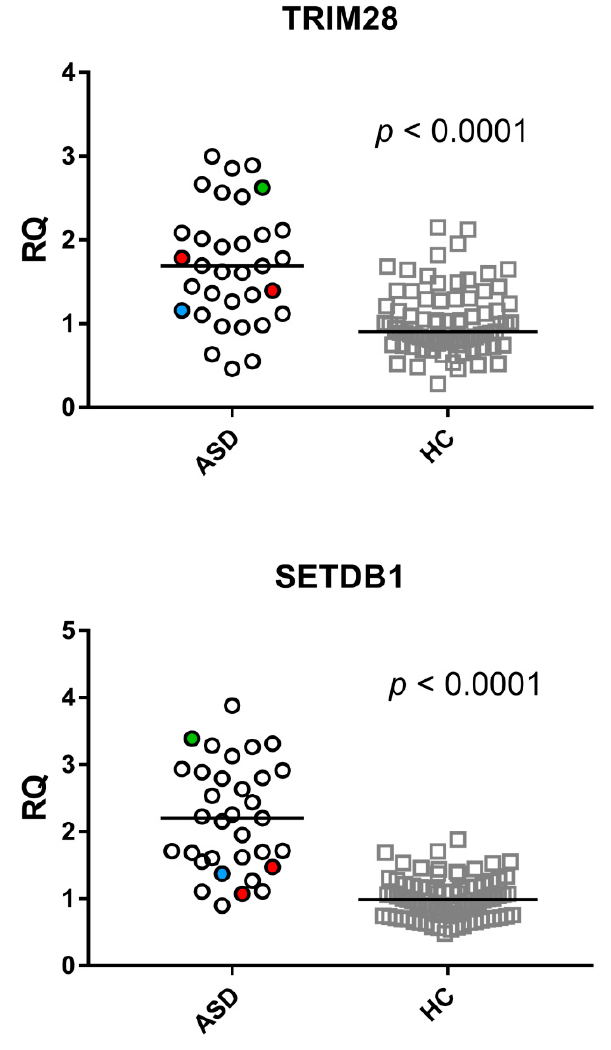
Figure 3. Expression of TRIM28 and SETDB1 in whole blood from 33 children with autism spectrum disorder (ASD) and 79 healthy controls (HC). RQ: relative quantification. Circles and squares show the median of three individual measurements, horizontal lines the median values. Red circles: values of two patients on valproic acid therapy. Green circle: value of the patient on aripiprazole therapy. Blue circle: value of the patient on cyproheptadine therapy. Statistical analysis: Mann–Whitney test was used to compare the transcriptional levels of each target gene between children with ASD and HC.